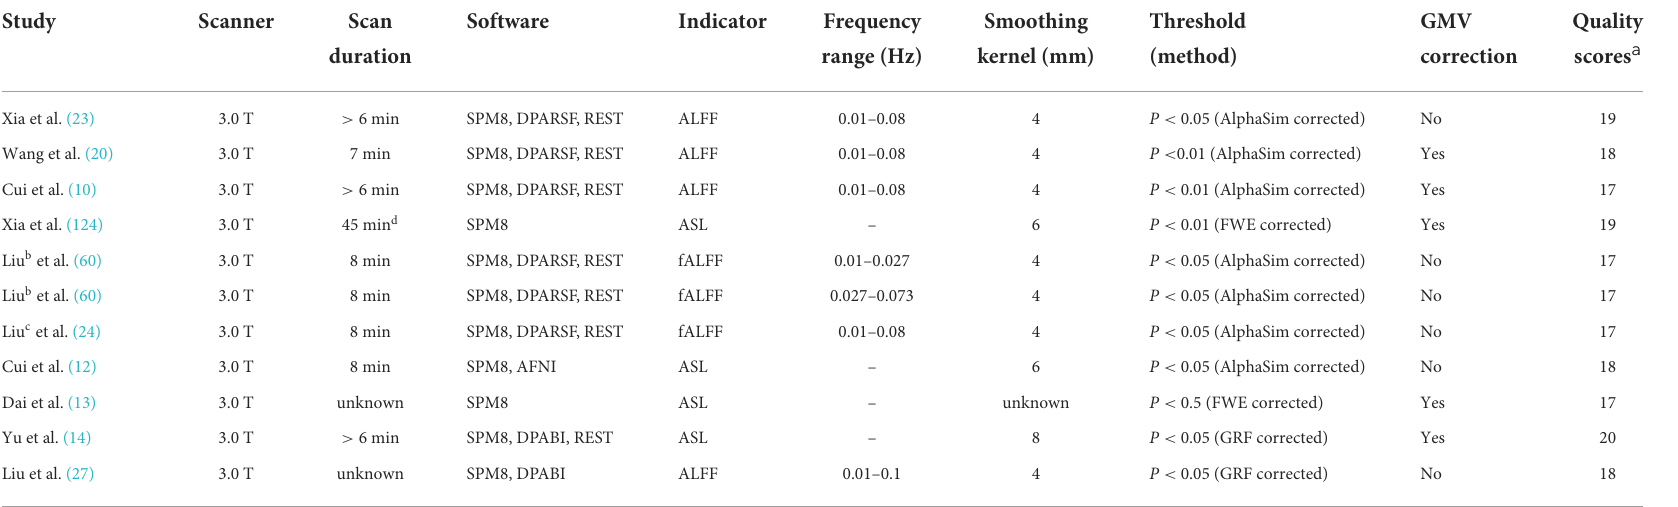
TABLE 4 Imaging characteristics of the studies included in the meta-analysis (group